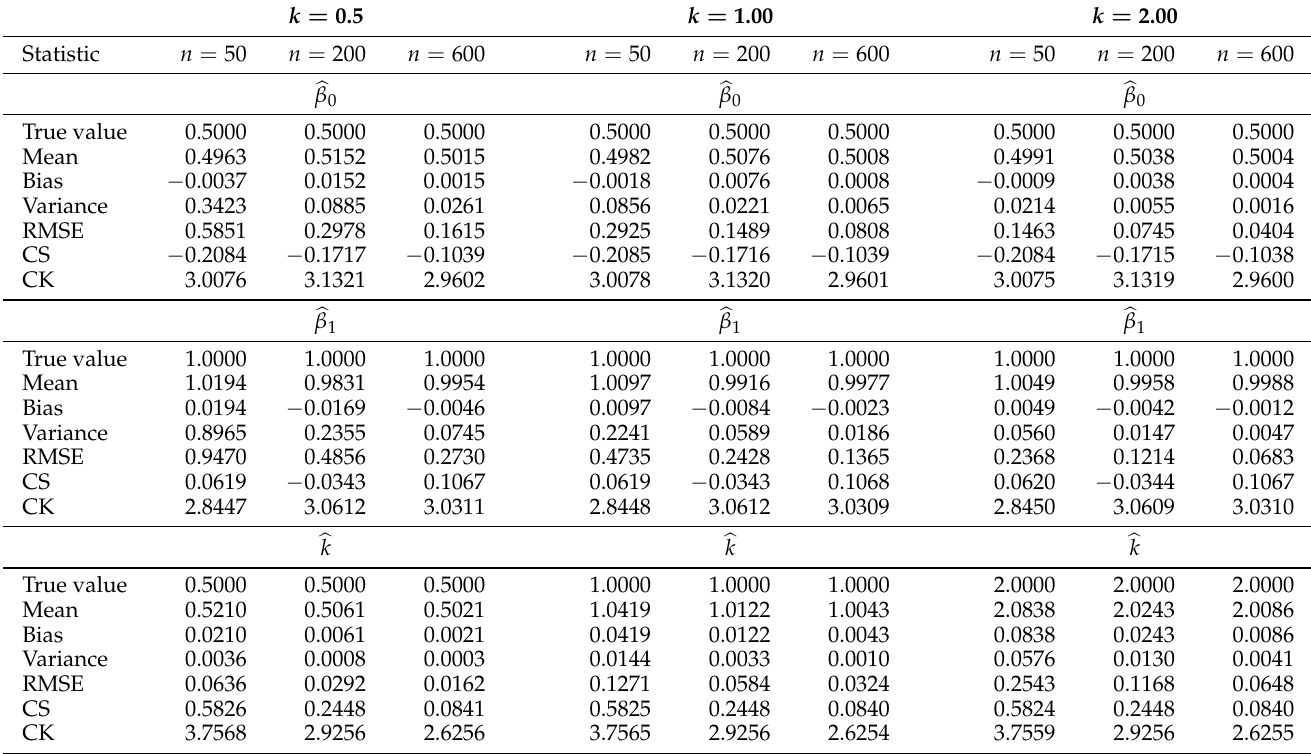
Table 3. Statistics from simulated Weibull regression data ( q = 0.50, β 0 = 0.50, β 1 = 1.00). k = 0.5